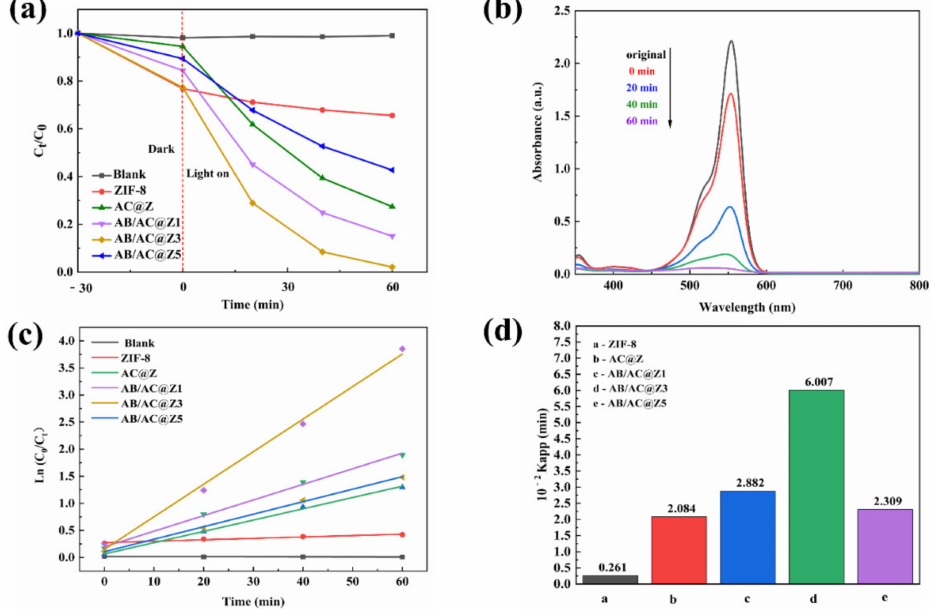
Figure 6. ( a ) The photodegradation of RhB with different materials. ( b ) UV-DRS of RhB solutions treated with AB/AC@Z3. ( c , d ) The first-order kinetic constants of different materials.